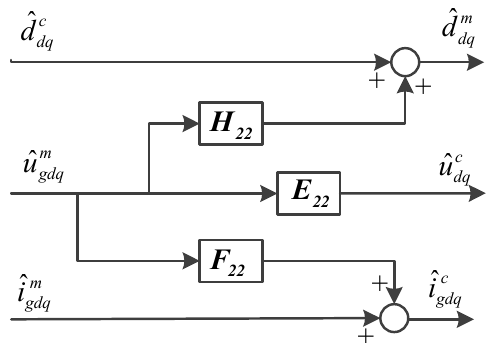
Figure 13. The small-signal transfer diagram of PLL in GSC control, which shows the transfer relationship of variables from the circuit module to the control module.